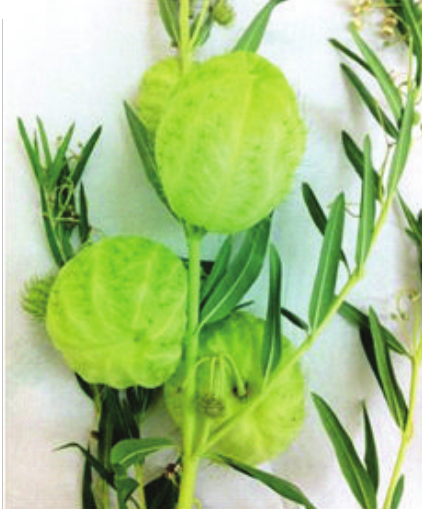
Figure 1: Specimen of Asclepias physocarpa brought by the patient.